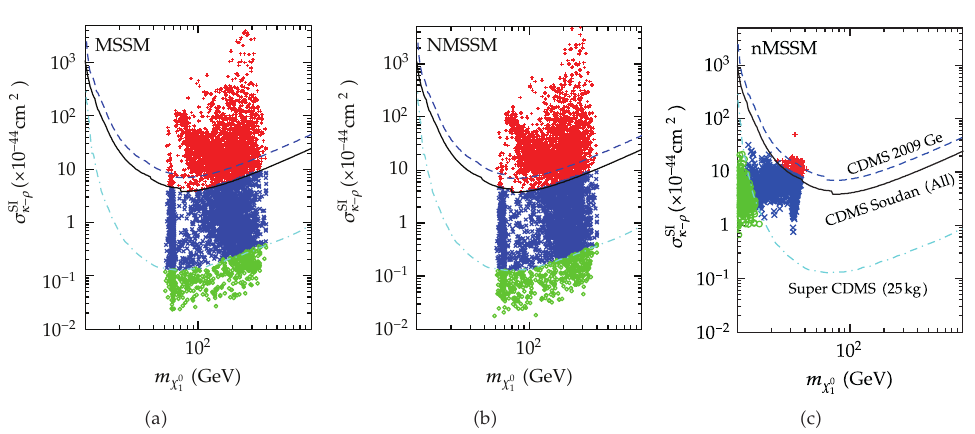
Figure 1: The scatter plots (cid:2) taken for (cid:5) 46 (cid:6)(cid:3) for the spin-independent elastic cross-section of (cid:2) χ -nucleon scattering. The “ (cid:8) ” points (cid:2) red (cid:3) are excluded by CDMS limits (cid:2) solid line (cid:3) , and the “ × ” (cid:2) blue (cid:3) would be further excluded by SuperCDMS 25kg (cid:5) 65 (cid:6) in case of nonobservation (cid:2) dash-dotted line (cid:3) , and the “ ◦ ” (cid:2) green (cid:3) are beyond the SuperCDMS